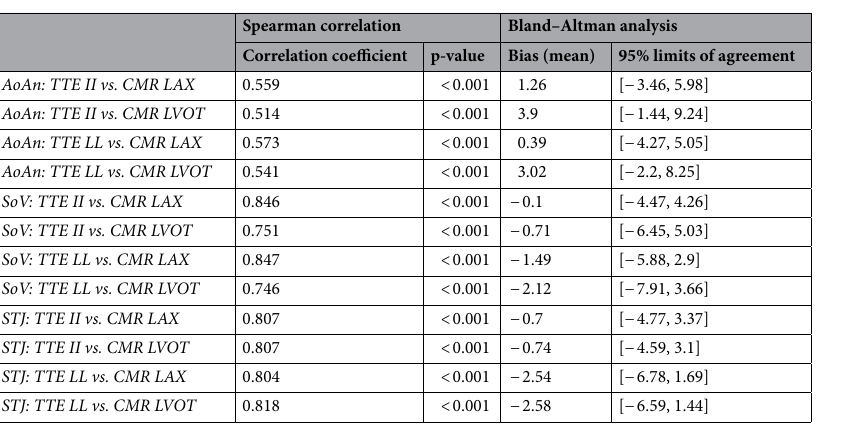
Table 4. Spearman correlation and Bland–Altman analysis of TTE and CMR measurements. II inner-edge to inner-edge, LL leading-edge to leading-edge. Other abbreviations as in Table 2.